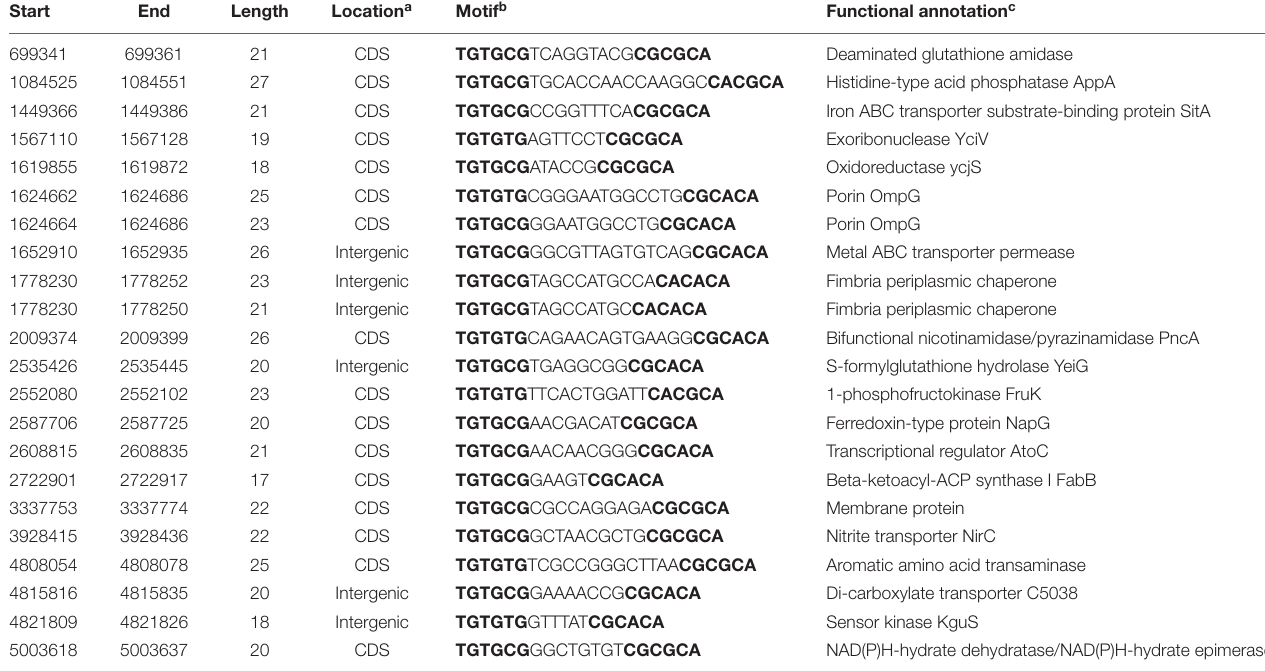
TABLE 3 | List of potential KguR binding sites identified by the Pattern Locator program. Start Length Location a Motif b Functional annotation